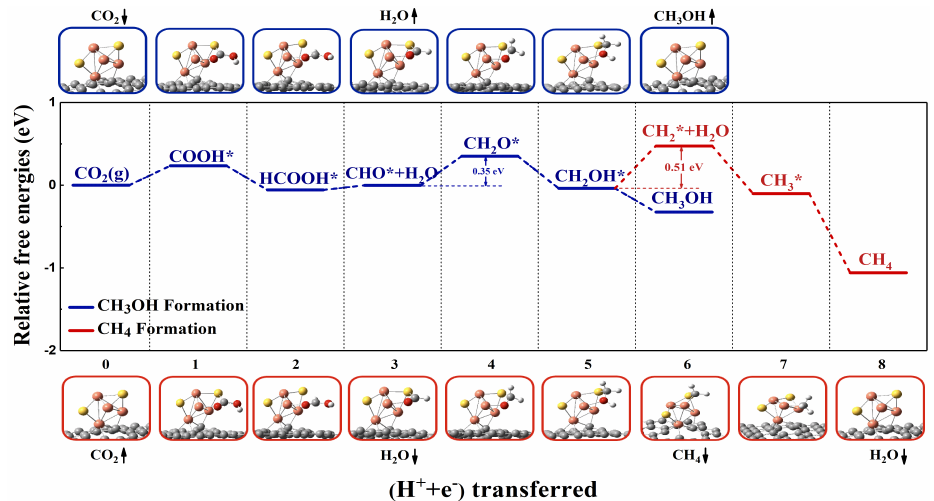
Figure 4. Reaction pathways for producing CH 3 OH and CH 4 on the Cu 4 S 2 /SV catalyst with no applied potential. (The blue line represents the methanol formation pathway which the intermediate products show in the upper part of the figure. The red line represents the methane formation pathway which the intermediate products show in the lower part of the